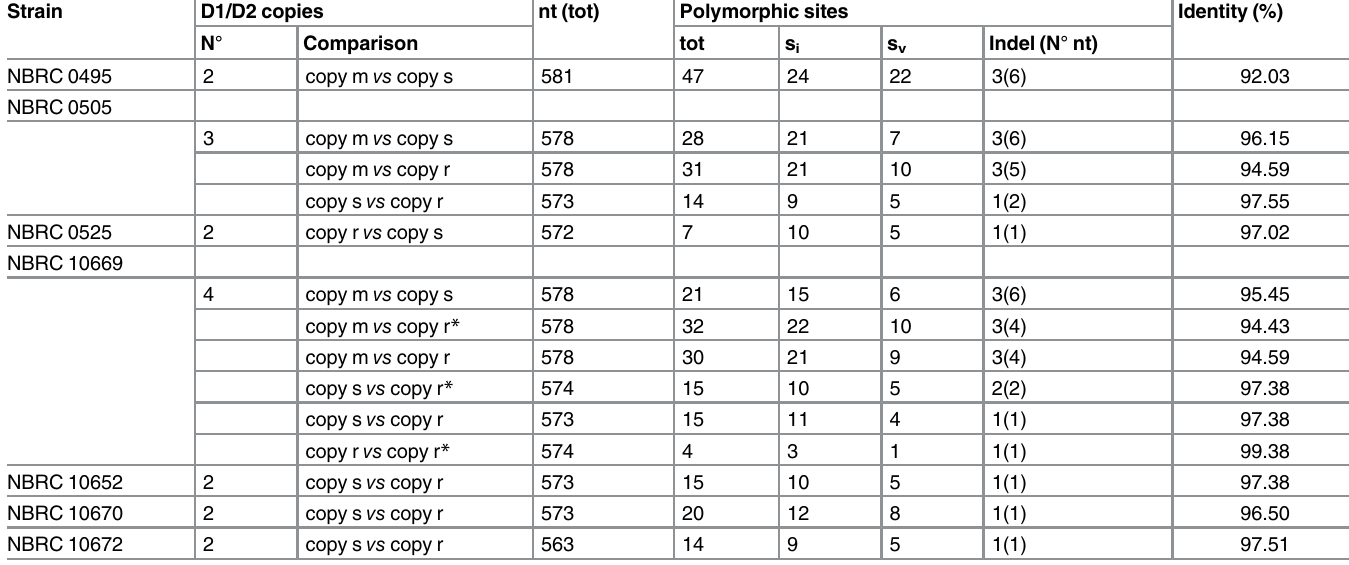
Table 3. Pairwise comparison of D1/D2 sequences cloned from strains with intra-genomically variable D1/D2 sequences. Intra-genomic D1/D2 vari- ants cloned from individual strains are indicated as D1/D2 copies. The number of transitional (s i ) and transversional (s v ) mutations, as well as number of indels and the involved nucleotides, were computed with MEGA6. The number of nucleotides in pairwise-aligned sequences is indicated as nt (tot), whereas the number of nucleotides in indels (N° nt) is reported in brackets. Identity (%) indicates the percentage of identical nucleotides between D1/D2 variants within individual